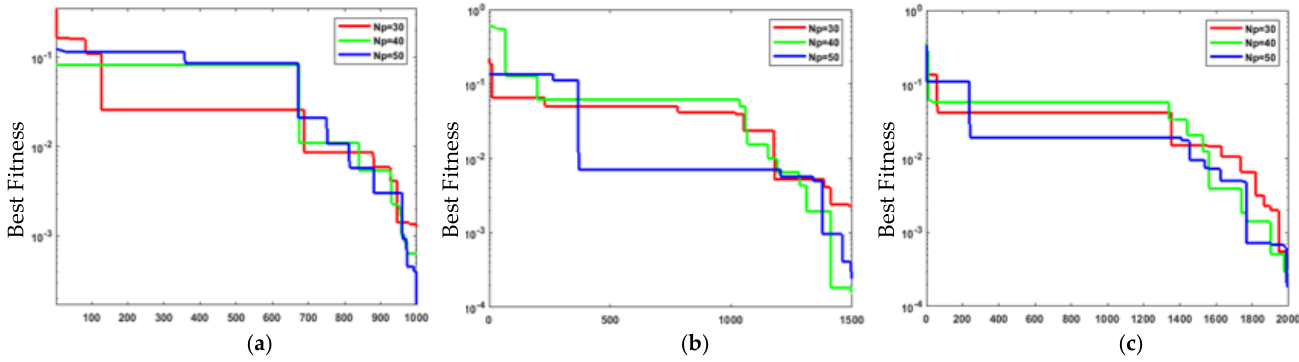
Figure 3. Fitness plots for AO with respect to population sizes. ( a ) T = 1000. ( b ) T = 1500. ( c ) T = 2000.